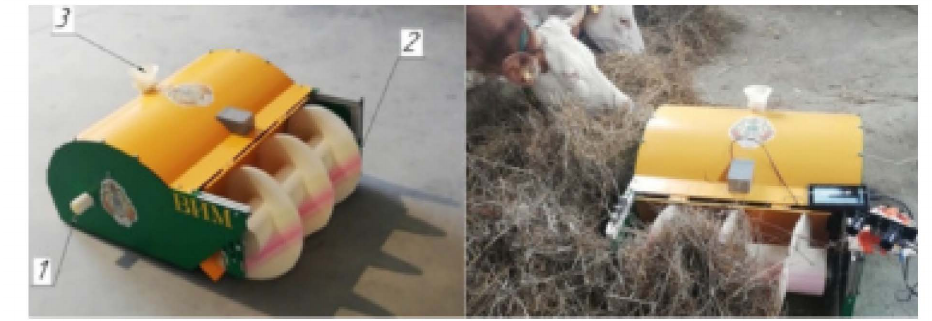
Figure 19. Physical analogue of a robot pusher: 1. Outlet of the feed additive dispenser; 2. Pusher auger; 3. Filler with closer